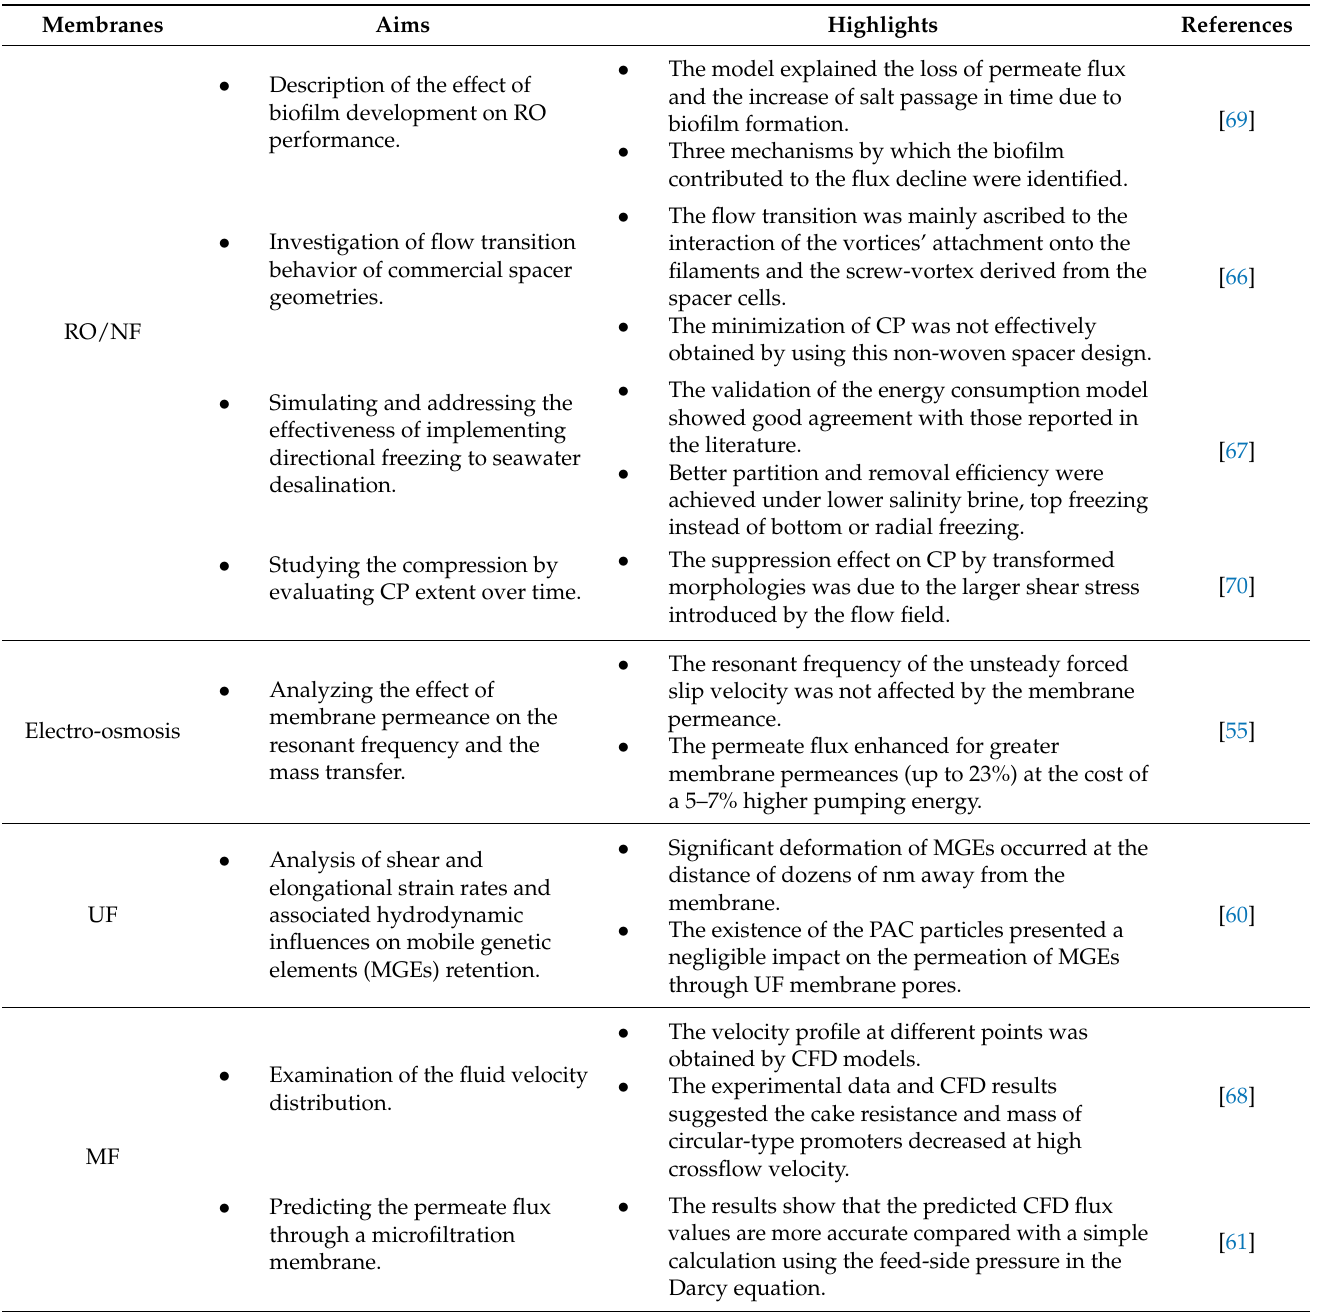
Table 1. Application of CFD for fouling simulation in different membrane systems from the literature.